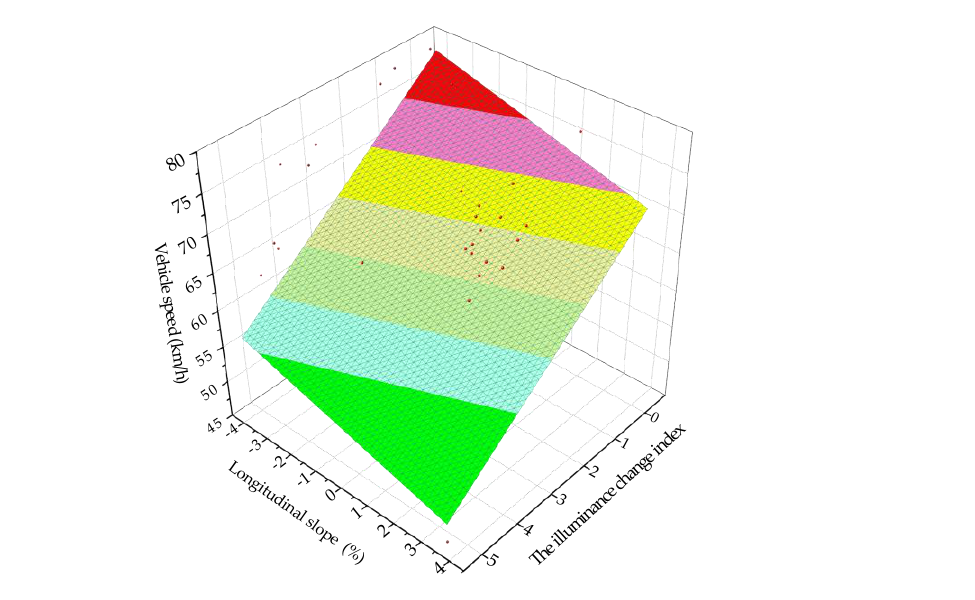
Figure 11. Fitting surface of the vehicle speed under the coupling effect of illuminance and longitudi- nal